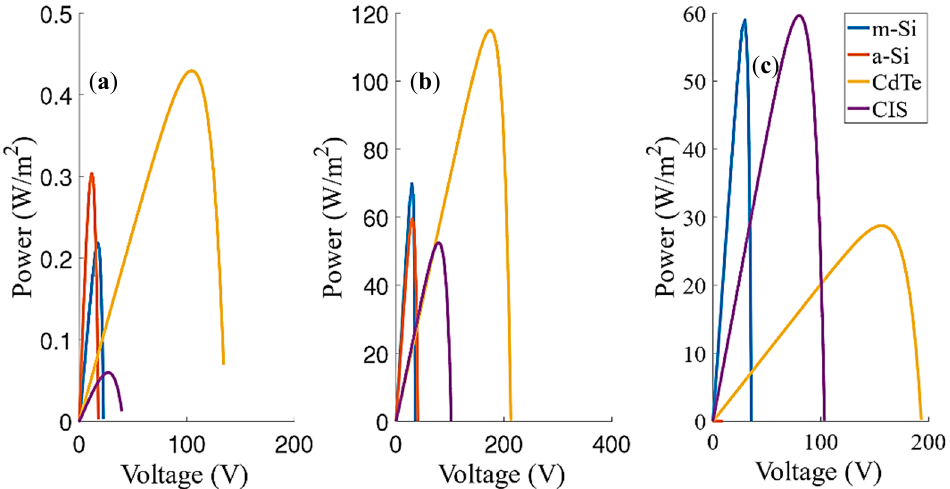
Figure 18. Simulated voltage-power curves for the m-Si, a-Si, CdTe, and CIS modules. ( a ) ultraviolet